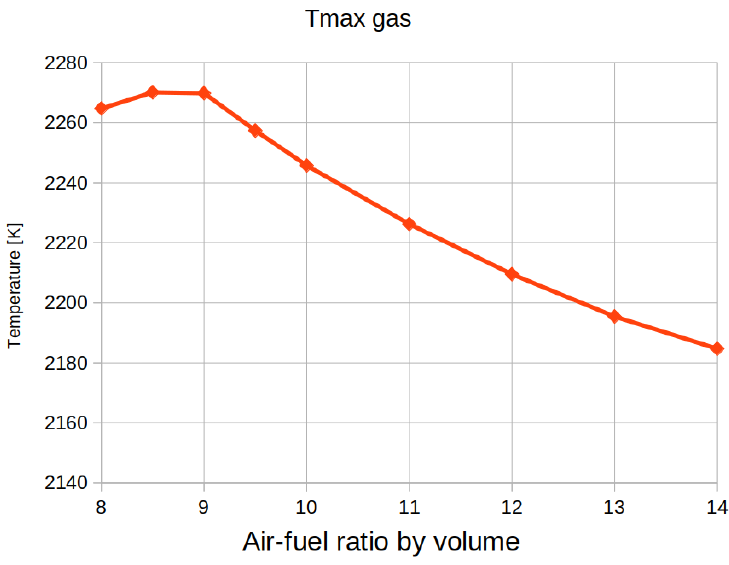
Figure 12. Computed maximum gas temperature for different